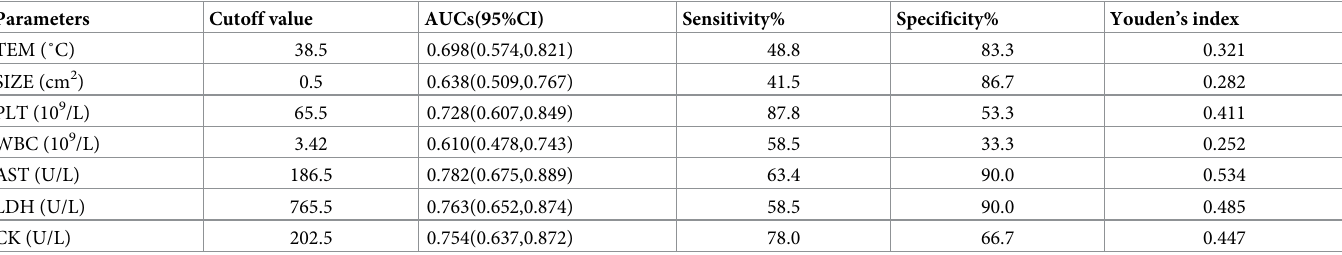
Table 5. Cutoff values and AUCs of different parameters for the prediction of severity of SFTS, with their sensitivity and specificity. Parameters